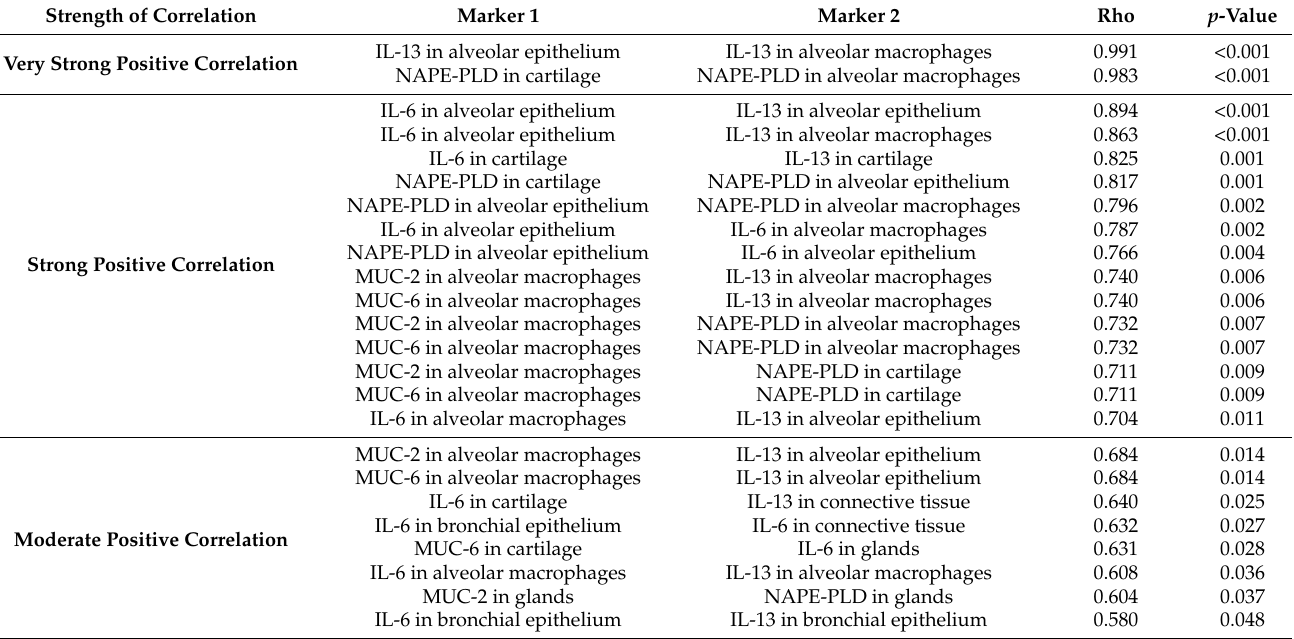
Table 5. Spearman’s rank correlation coefficient revealed correlations between the relative numbers of different factors in the pseudostratified ciliated epithelium